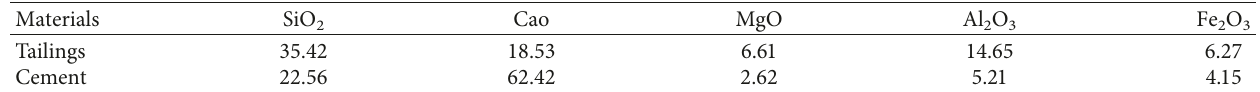
Table 1: The chemical composition of the materials.